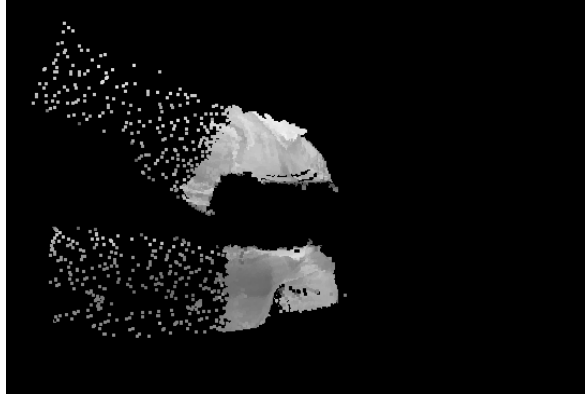
Figure 11. 3d view of the segmented point cloud of the person with interpolated thermal infrared intensity